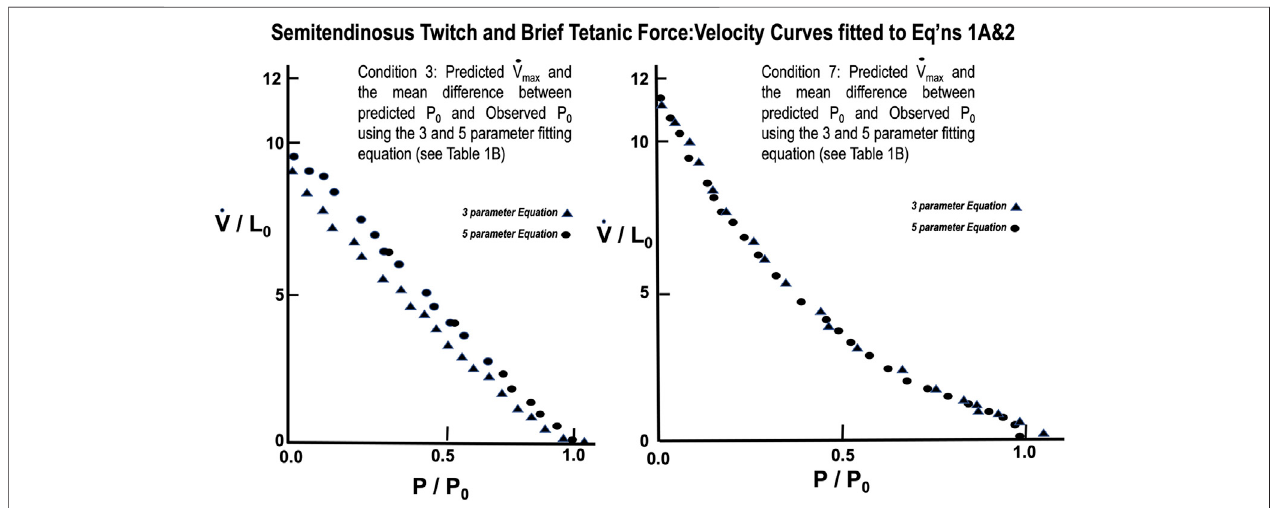
FIGURE13| ForceVelocitycurvesofobserveddatafromsemitendinosuswithTwitch(L)andBriefTetanic(R)stimulations fi ttedto Eqs1A , 2 .Comparisonofthe fi t for the two equations was signi fi cantly better for Eq. 2 ( p < 0.05).